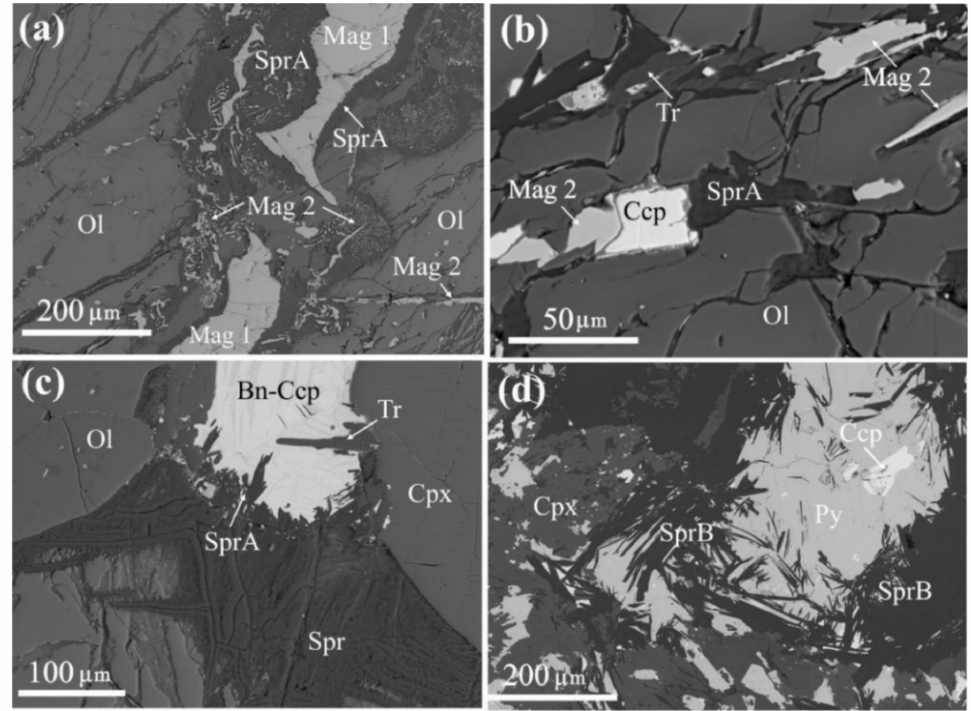
Figure 8. Serpentinite in samples of clinopyroxenites I ( a , b ), II ( c ), and III ( d ). ( a ) Relationships of serpentine A (Spr A) with primary (Mag 1) and secondary magnetite (Mag 2) in large olivine grain (Ol); ( b ) microcracks in olivine (Ol) filled with serpentine A (Spr A), tremolite (Tr), chalcopyrite (Ccp), and secondary magnetite (Mag 2); ( c ) localization of serpentine A (Spr A) and sulfides of bornite–chalcopyrite paragenesis (Bn-Ccp) in interstices of olivine (Ol) and clinopyroxene (Cpx) grains. Serpentine A (Spr A) together with tremolite (Tr) corrodes the marginal part of sulfide segregation; ( d ) fibrous aggregates of serpentine B (Srp B) corroding the marginal parts of large segregation of pyrite